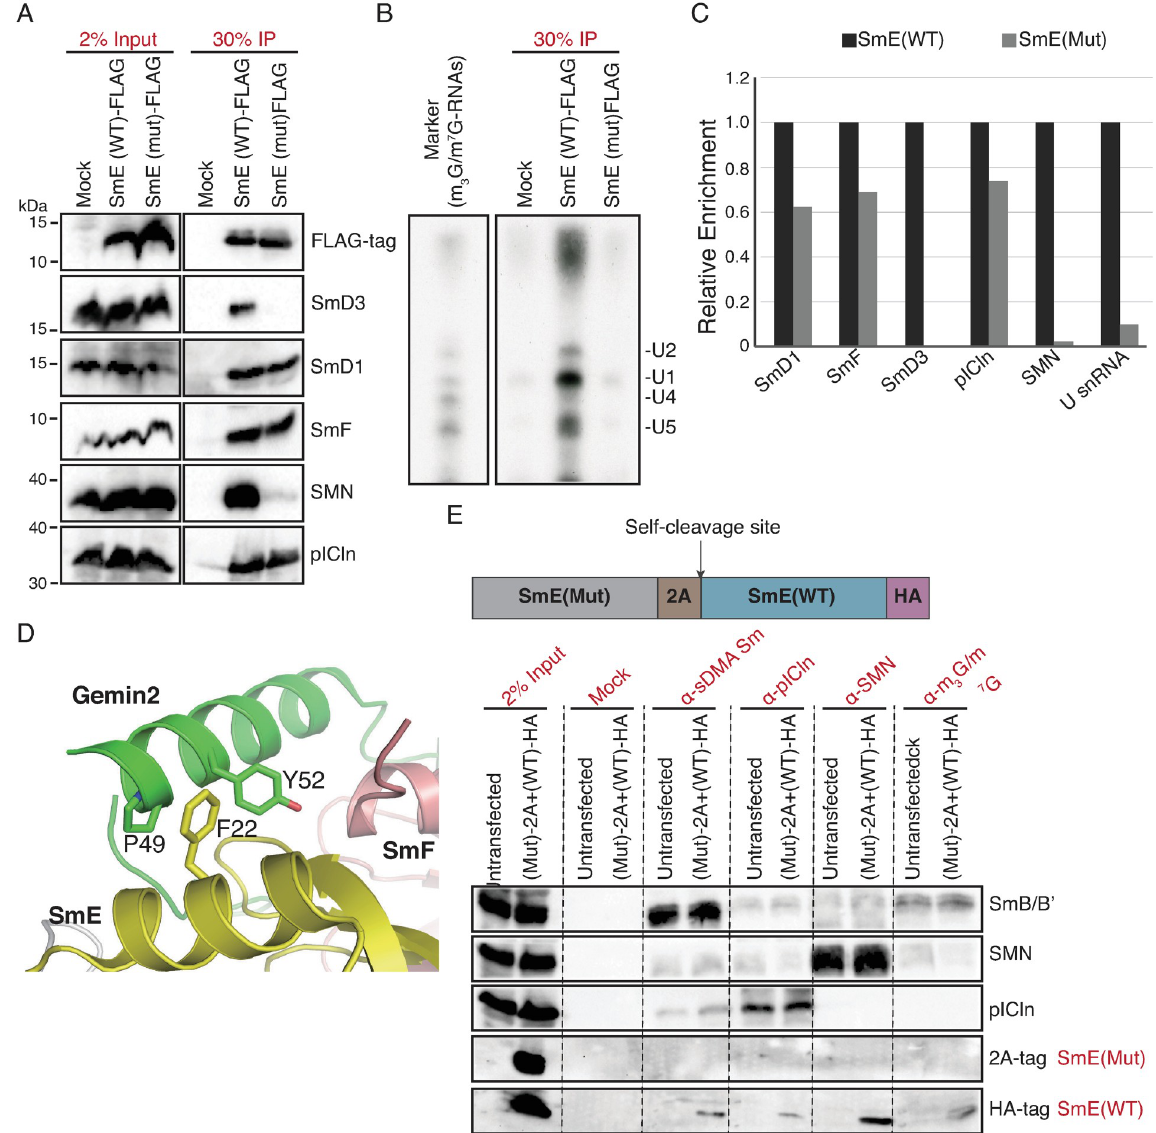
Fig 2. The missense mutation impairs the biogenesis of spliceosomal U snRNPs during Sm core assembly. (A-E), The NSM mutation in SmE impairs its interaction with U snRNP assembly machinery and incorporation into U snRNPs. (A), Anti-FLAG immunoprecipitation after transient transfection in HEK293T cells and western blotting analysis for co-precipitated U snRNP intermediates. Mock immunoprecipitations were performed with untransfected lysates. (B), 3’-end labeling of co-precipitated RNA and autoradiography. RNA immunoprecipitated using the H20 antibody against m 3 G/m 7 G cap of U snRNAs was used as reference. (C), Quantification of the data shown in A and B from two independent biological replicates, with black bars representing wild type and gray bars representing mutant SmE. (D), Predicted structural model for interference of the SmE mutation in its interaction with Gemin2, based on the PDB structure 4V98. (E), Immunoprecipitation using antibodies specific to Sm proteins, SMN, pICn and U snRNA cap, with lysates from HEK293T cells transfected with dual expression plasmid encoding 2A-tagged mutant SmE and HA-tagged wild type SmE and western blotting to analyze the integration of the wild type and mutant SmE into U snRNP biogenesis pathway. Since the interaction of mutant SmE with the SMN complex is affected, we used the previ- ously published structure of the 8S U snRNP assembly intermediate (Gemin2-SMN Δ C bound to 6S, PDB entry 4V98) [37], to in silico model the effect of the mutation. As evident from structural data of Gemin2 in association with Sm proteins, Phe22 of SmE is part of a binding